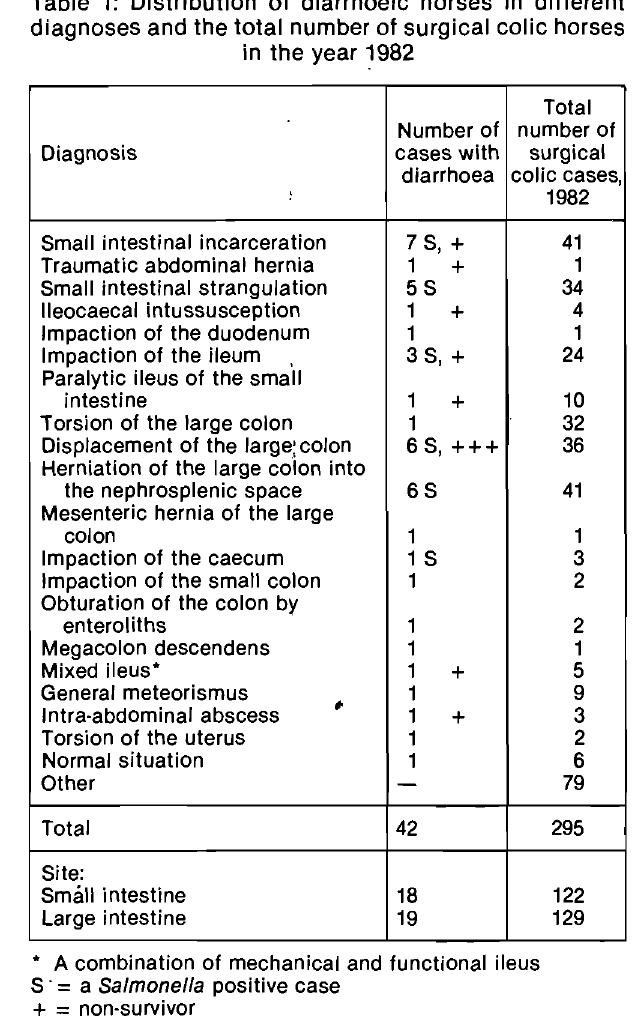
Table 1: Distribution of diarrhoeic horses in different diagnoses and the total number of surgical colic horses in the year 1982 Total Number of number of Diagnosis cases with surgical diarrhoea colic